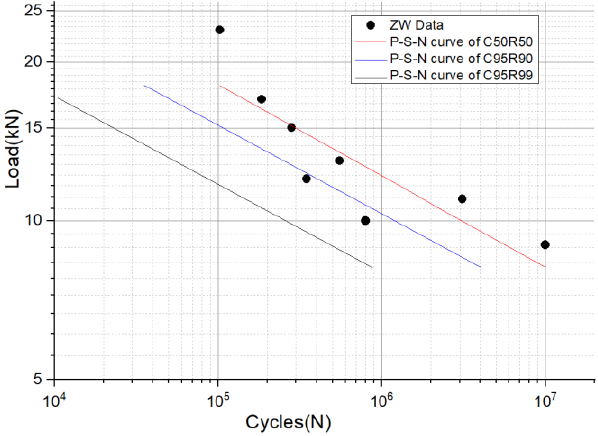
Figure 15. Load – life curve and probability load – life